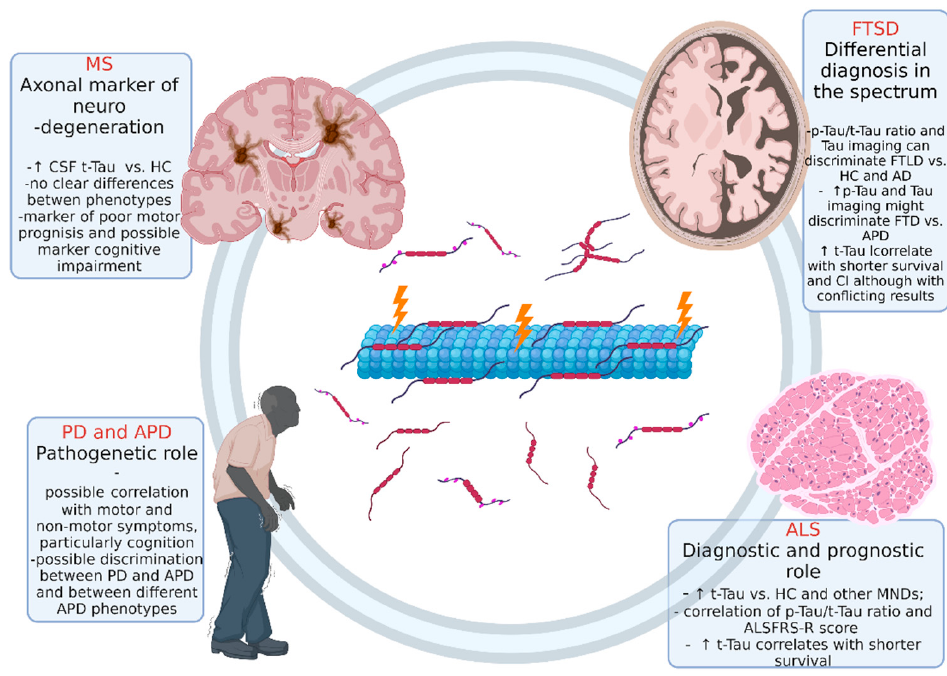
Figure 2. Overview of the role of Tau protein in different non-AD neurodegenerative disease. Abbreviations: ALS: amyotrophic lateral sclerosis, FTSD: frontotemporal spectrum disorder; MS: multiple sclerosis; PD: Parkinson’s disease. Figure created with Biorender.com.